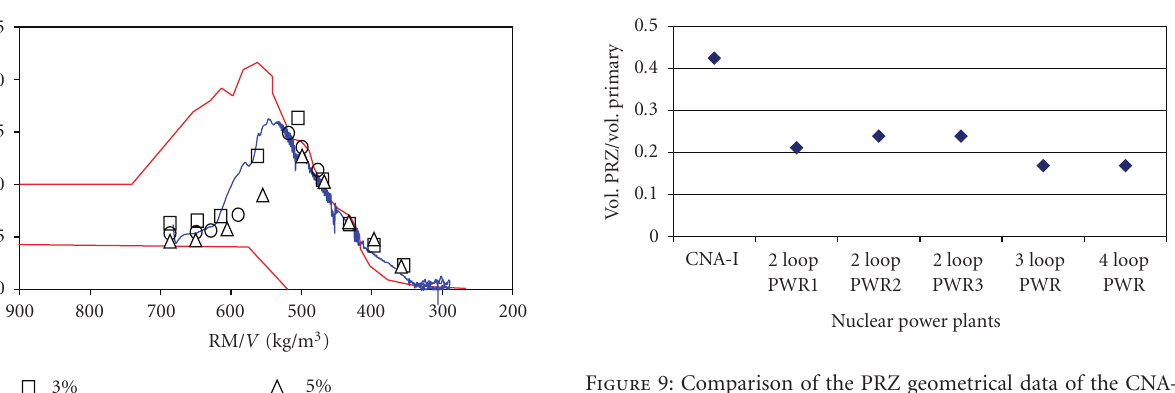
Figure 9: Comparison of the PRZ geometrical data of the CNA-I with other PWRs.